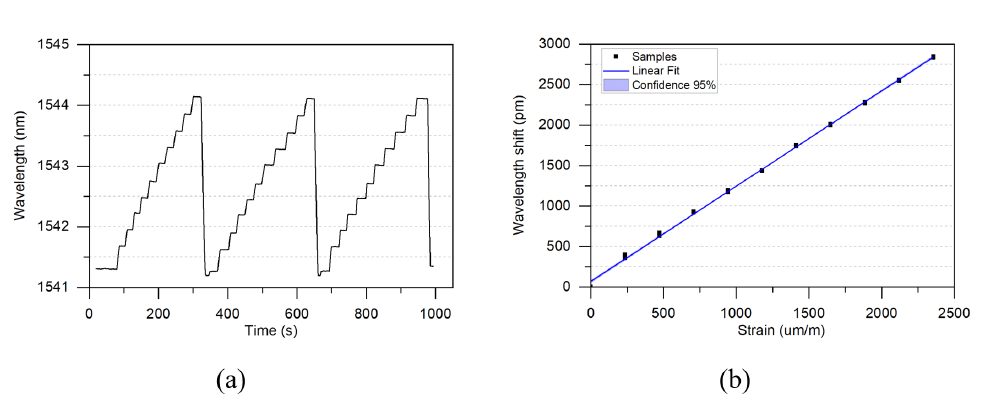
Figure 6. Sensor calibration: (a) Strain cycles during calibration and (b) FBG linear